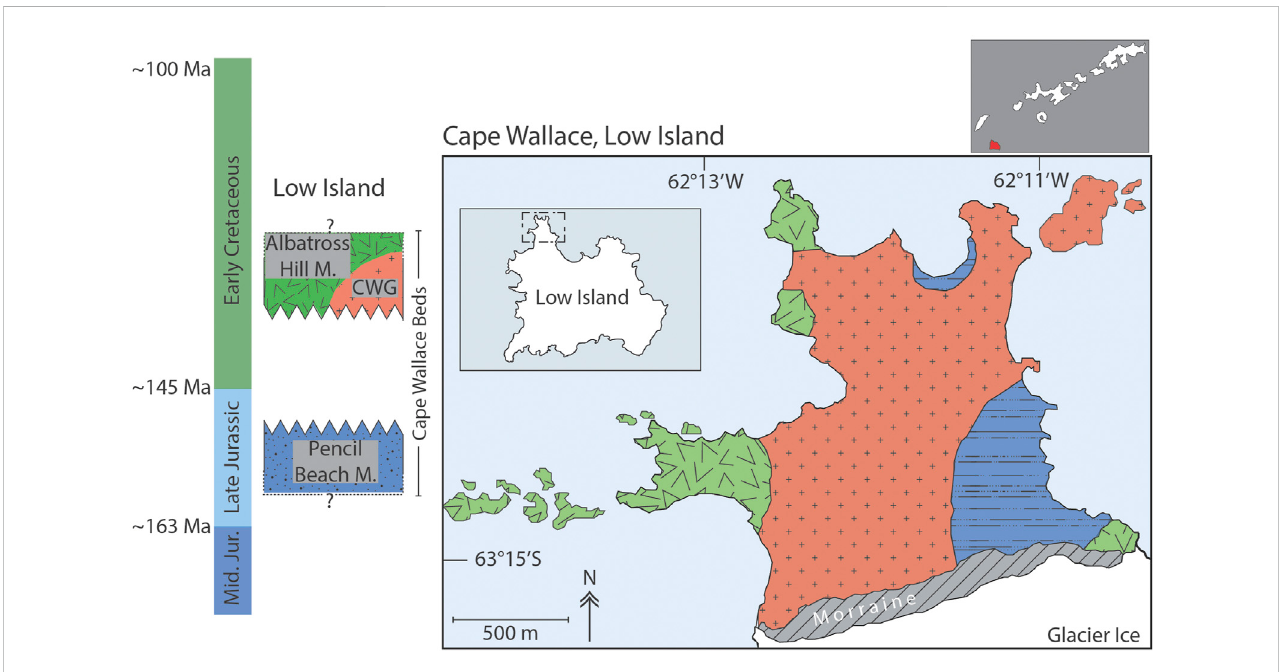
FIGURE 3 Revised geological map of Cape Wallace, Low Island, modi fi ed from Bastias